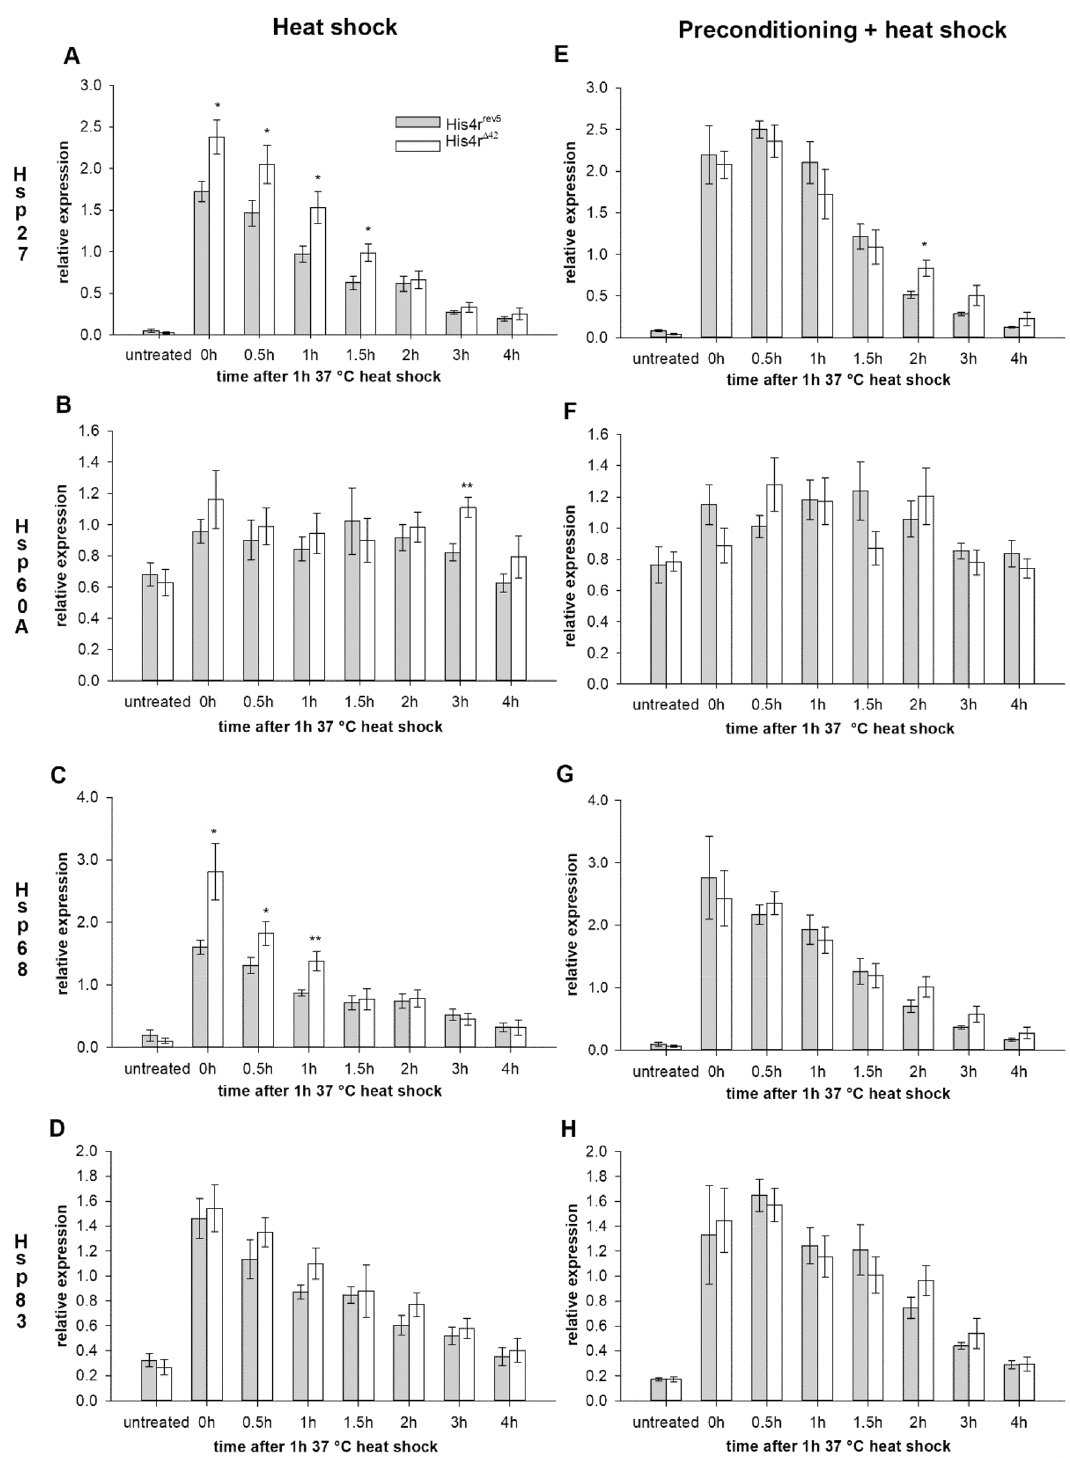
Figure 6. His4r affects HSP gene induction after heat shock. The transcript levels of Hsp27 ( A ), Hsp68 ( C ) and Hsp83 ( D ) HSP genes showed dramatic increase after 37 °C heat shock (P < 0.001, Kruskal–Wallis Test) both in His4r mutants (white) and controls (grey) that gradually decreased during the post-heat shock incubation period, while there was no change in the expression of Hsp60A ( B ). However, following heat shock the transcript levels of Hsp27 (A) and Hsp68 (C) were significantly higher in His4r mutants than in controls. ( E–H ) After preconditioning at 34 °C the expression of HSP genes in His4r rev5 controls reaches the same elevated levels as in His4r Δ42 flies. Asterisks mark significant differences between His4r Δ42 and His4r rev5 samples, *P < 0.05, **P < 10 −2 , Mann–Whitney U